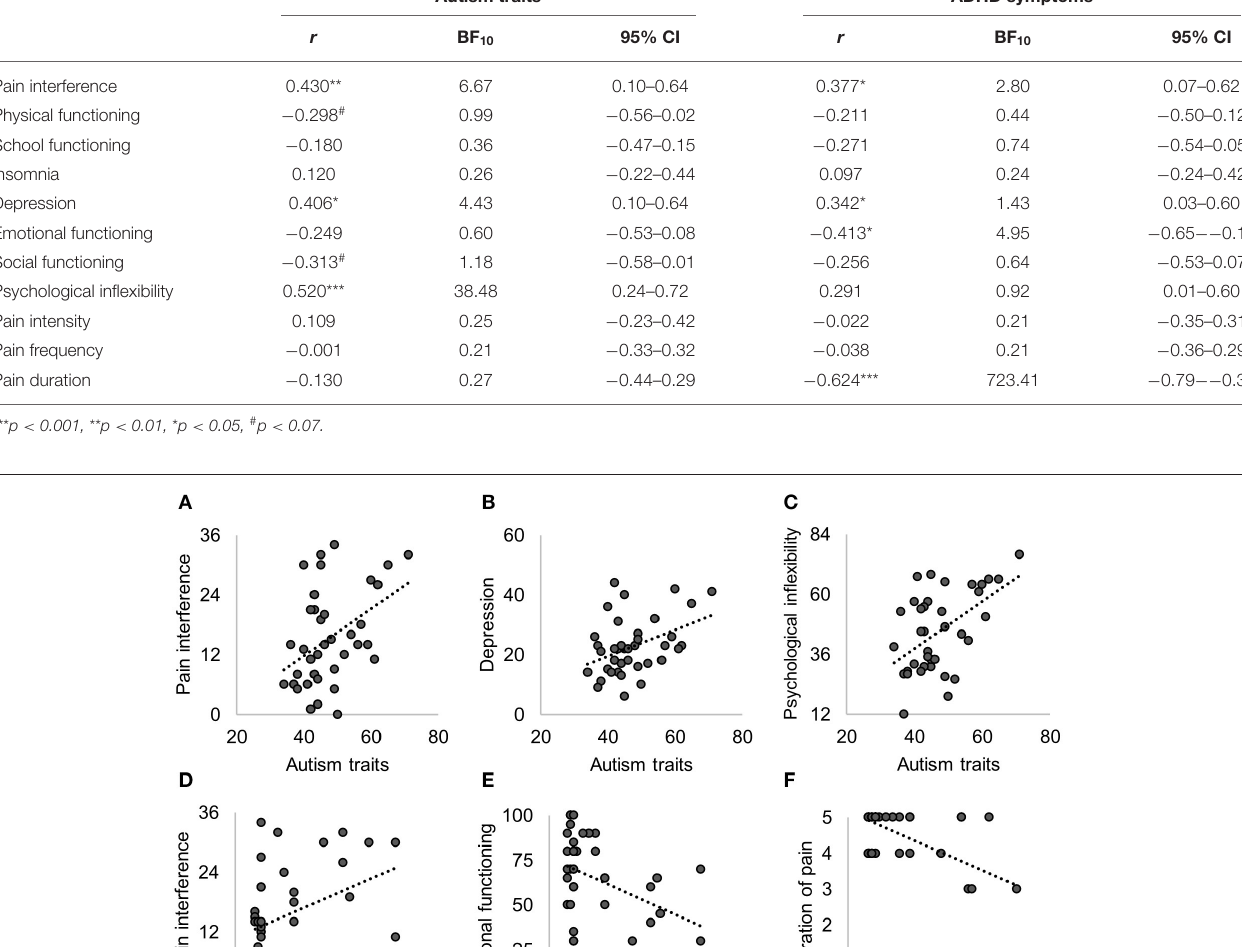
shown in Table 2 . All non-significant correlation plots are shown in Supplementary Figure 1